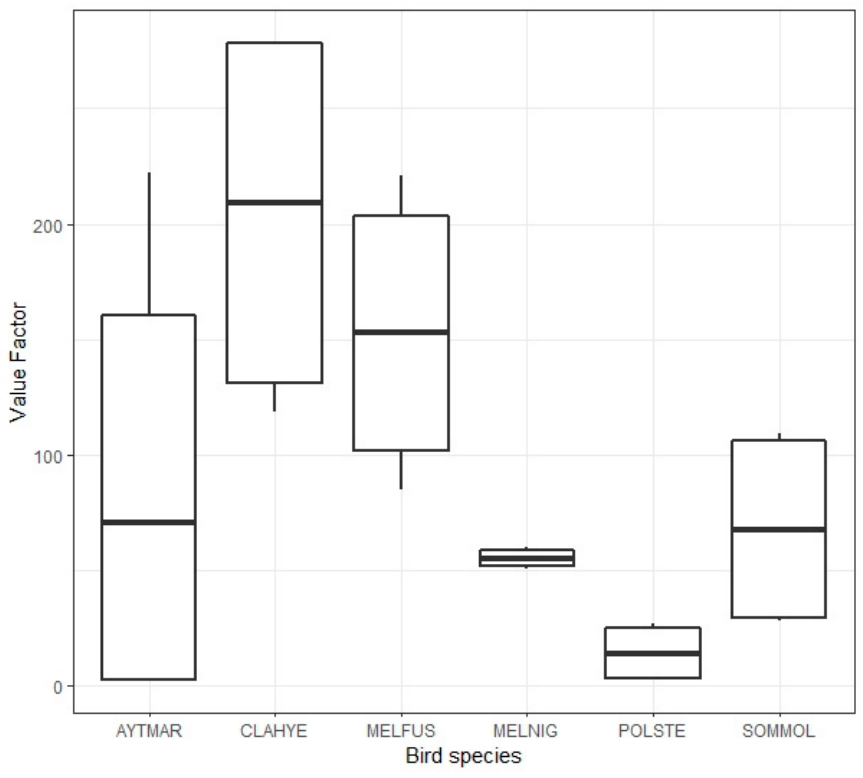
Figure 2. Value factors (VFs) for the most numerous waterbird (seaducks) species present during the non-breeding period in the Baltic Sea. Horizontal thick line—mean. Species abbreviations: AYTMAR—Greater Scaup, CLAHYE—Long-tailed Duck, MELFUS—Velvet Scoter, MELNIG—Common Scoter, POLSTE—Steller’s Eider, SOMMOL—Common Eider.